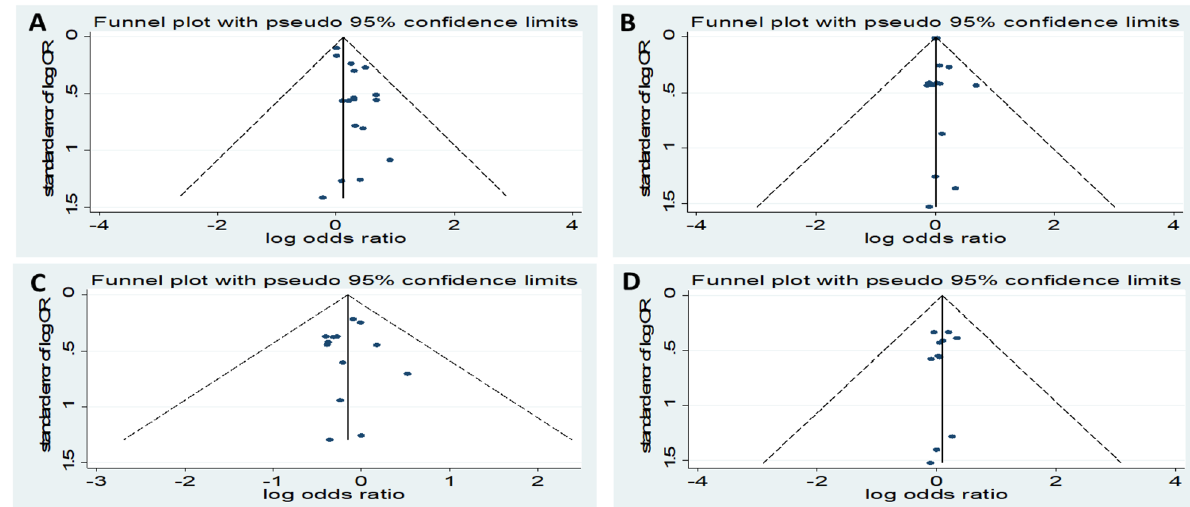
Figure 7. Publication bias funnel plots of the OR for ( A ) TG, ( B ) TC, ( C ) HDL, and ( D ) LDL and